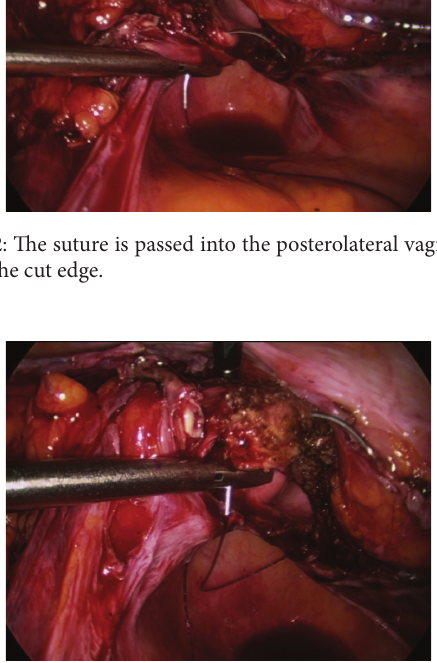
Figure 3: The anterolateral vaginal wall is pierced 5mm deep from the cut edge and exits to include the cut fibers of the pubocervical fascia.